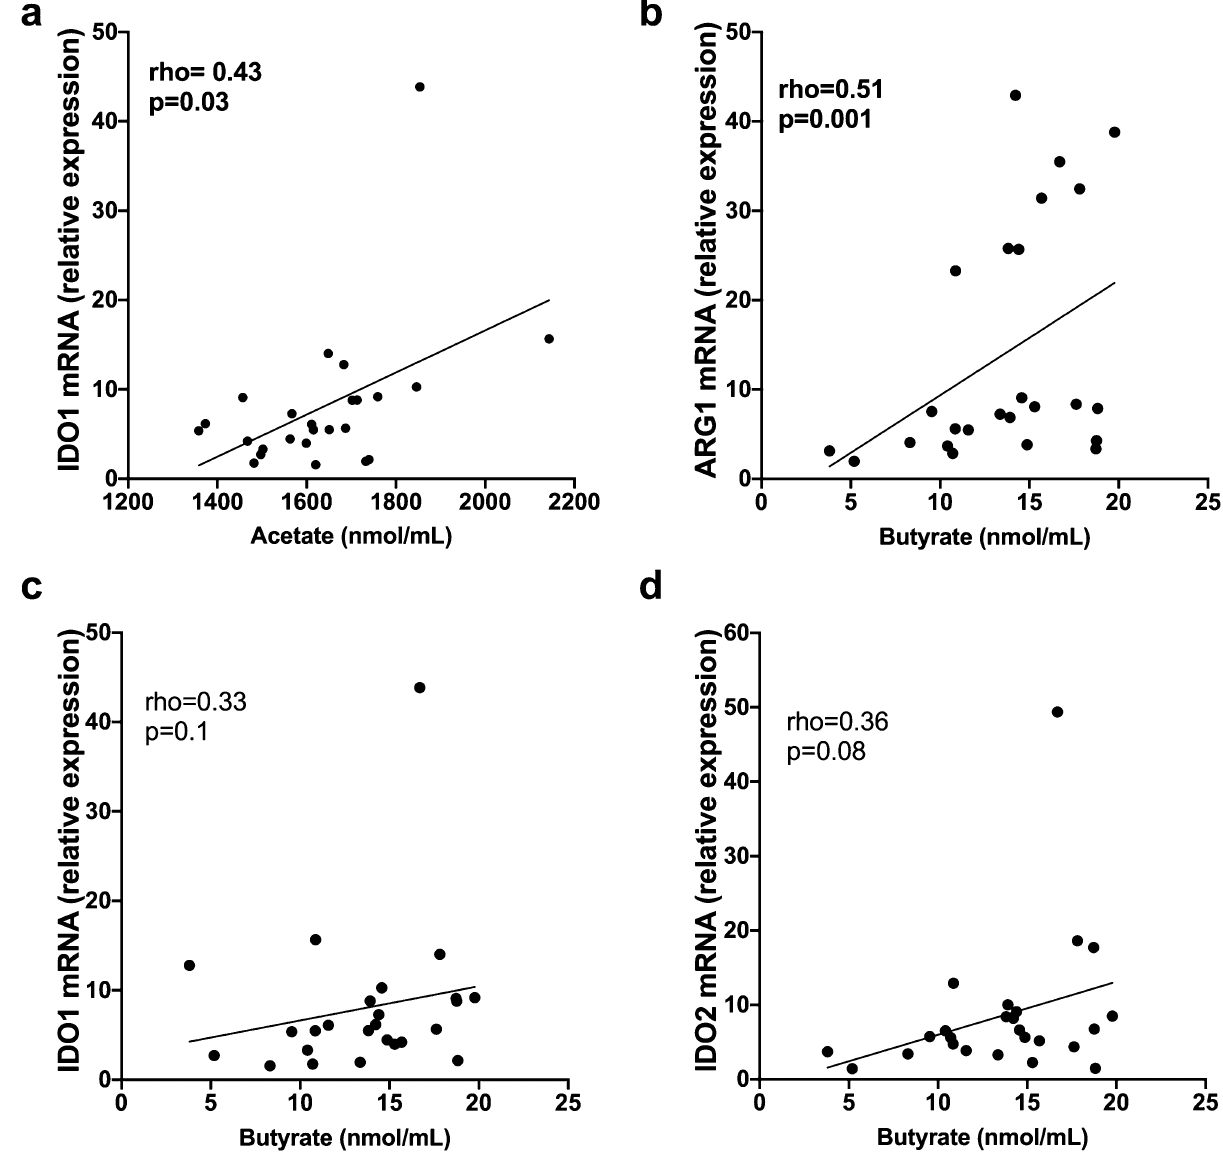
Figure 6. Correlations between serum levels of SCFA in patients with CIS/MS and PBMC mRNA for IDO and ARG (n = 25). (a) Correlation of IDO1 mRNA with acetate; (b) Correlation of ARG1 with butyrate; (c) Correlation of IDO1 mRNA with butyrate; and (d) Correlation of IDO2 mRNA with butyrate. Correlation was measured using nonparametric Spearman’s rho; statistically significant values are shown in bolded font. Line of regression is shown for illustrative purposes